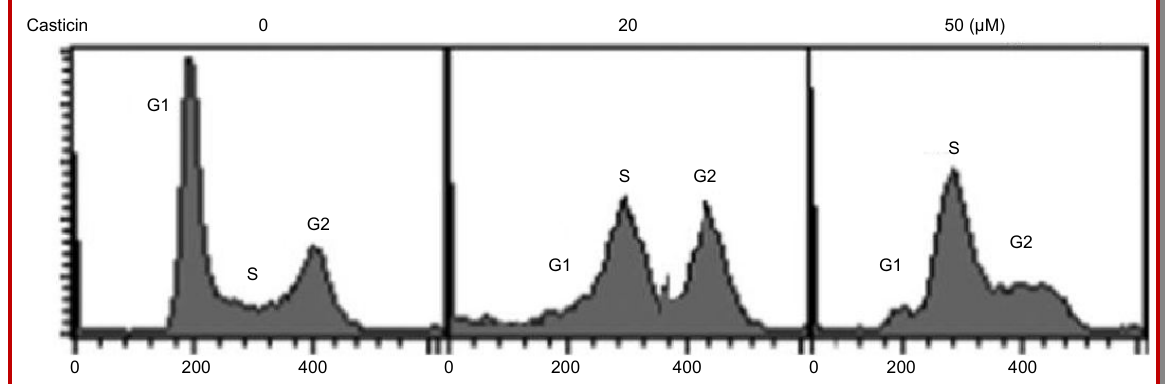
Figure 3: Casticin treatment inhibited the migration of TE-1 cells. Migration capacity of TE-1 cells was analyzed after 24 and 48 hours of casticin treatment